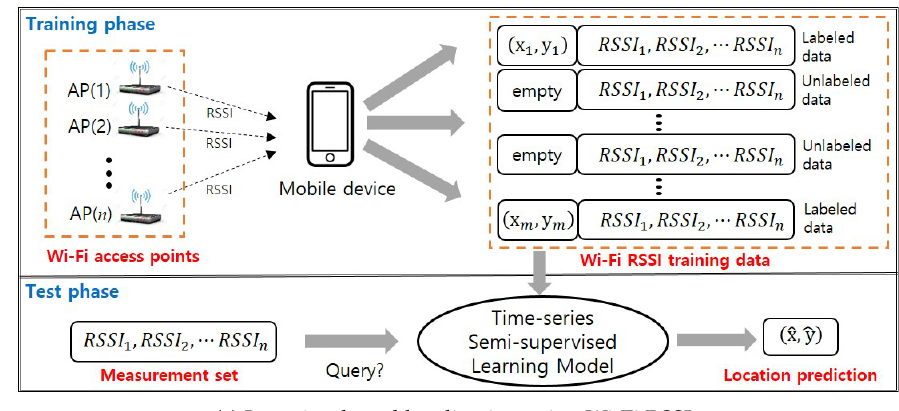
Figure 1. ( a ) Experimental floor with the 8 visible Wi-Fi access points, ( b ) Wi-Fi RSSI distribution of the #3 access point across the floor, and ( c ) learning-based localization architecture using Wi-Fi RSSI. Labeled training data are obtained by placing the receiver at different locations. Let us define the Wi-Fi observation set as x i = { z i 1 , . . . , z in } ∈ R n received from n different APs ( n = 8 in this paper), where z ij (1 ≤ j ≤ n ) is a scalar RSSI measurement sent from the j -th access point corresponding to the user’s location ( y Xi , y Yi ) . Total of the l labeled training data are given by { x i } l with x i ∈ X ⊆ R n , i = 1 and { y Xi } l , { y Yi } l . The unlabeled data set { x i } l + u consists of only the RSSI i = 1 i = 1 i = l + 1